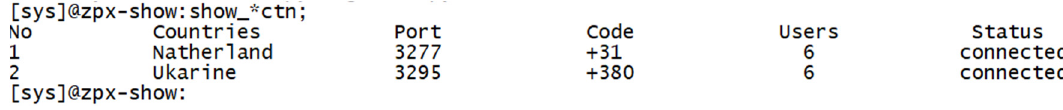
Figure 13. Countries connected to cloud servers.